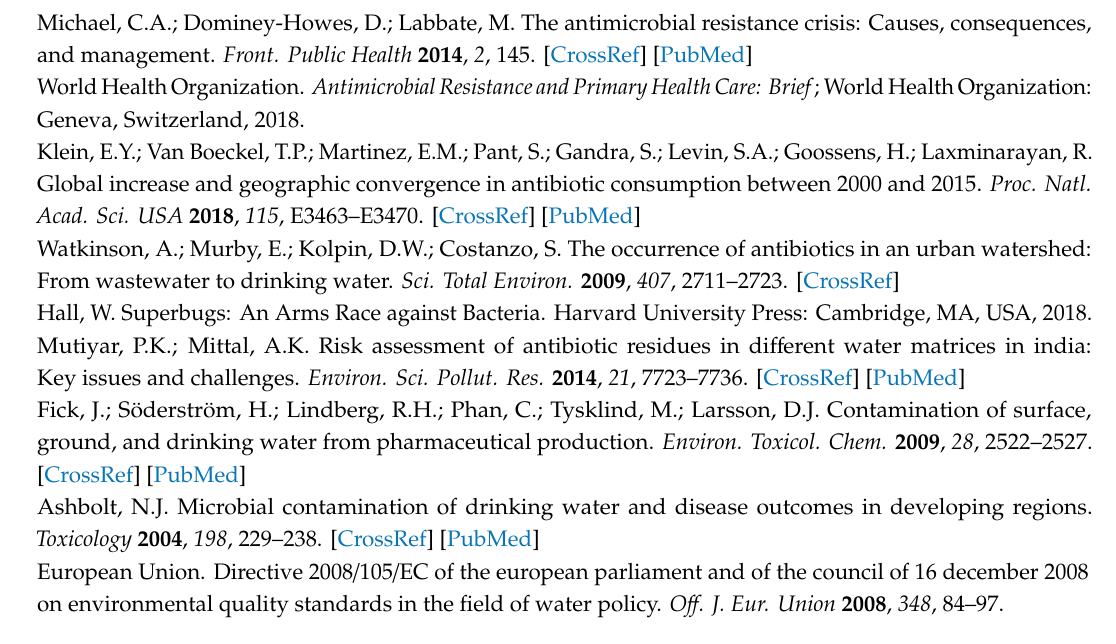
Figure S1: ( A ) SEM image (2 k magnification) of MIP 2 microparticles immobilized onto an SPE using polypyrrole. ( B ) SEM image (1 k magnification) of thin film of polymer made directly on an SPE. Figure S2: Schematic image of the flow cell used in the experiments. The SPE is placed in the central chamber, which is sealed with an O-ring. The thermocouple (T 2 ) is measured throughout the experiment (1 second = 1 data point). Solutions of analyte are injected into the inflow and the system is allowed to stabilise for 30 min before the next